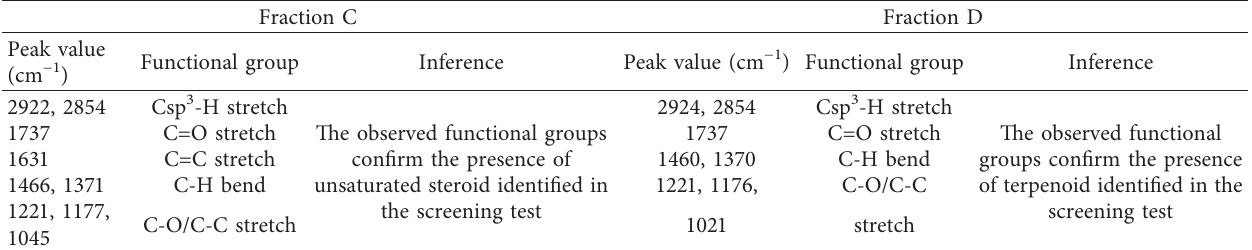
Table 12: FTIR interpretation of purified fractions C and D from the methanol extract of V. camporum